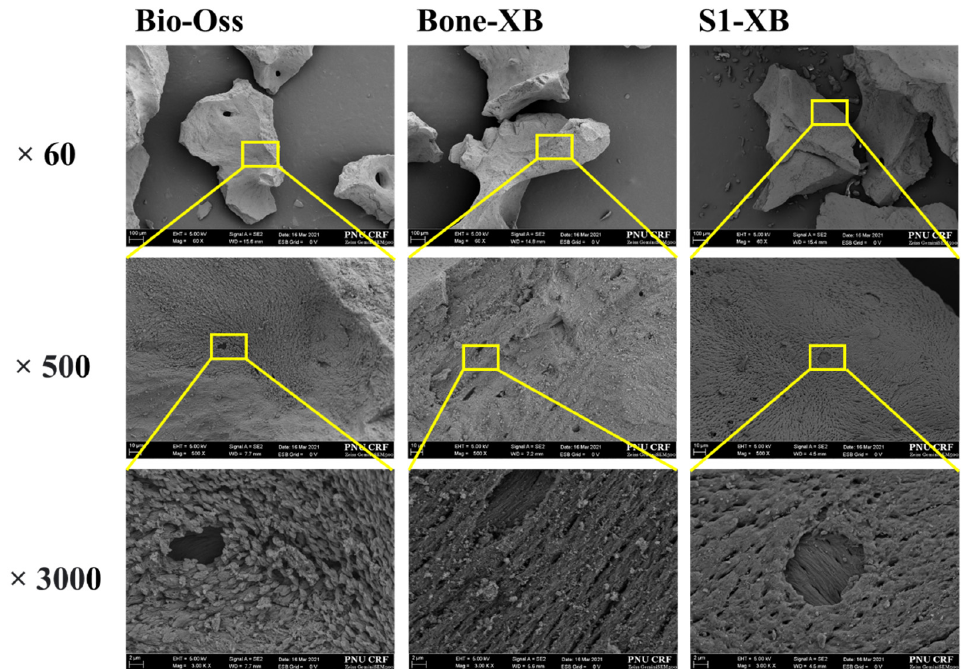
Figure 3. Scanning electron microscope (SEM) images of each group. [Original magnification: ×60, ×500, ×3000.